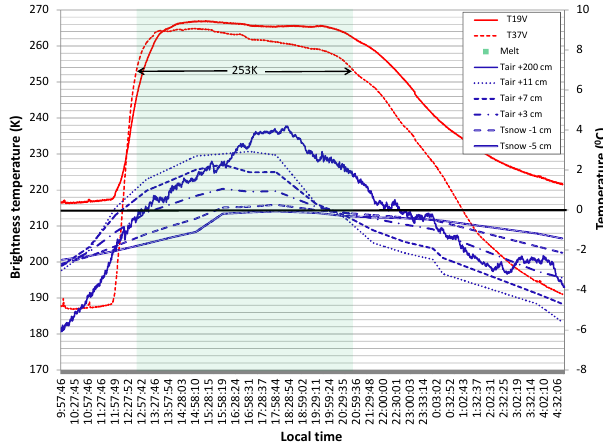
Figure 4. Time series of the surface-based radiometer T B and the air/snow temperature measurements recorded during 12– 13 April 2010 at Churchill MB (58.74 ◦ N, 93.82 ◦ W). The green shaded region highlights the period when the winter T B D algorithm successfully detected a winter melt event, the onset of which coin- cides very closely with the 2m air temperature